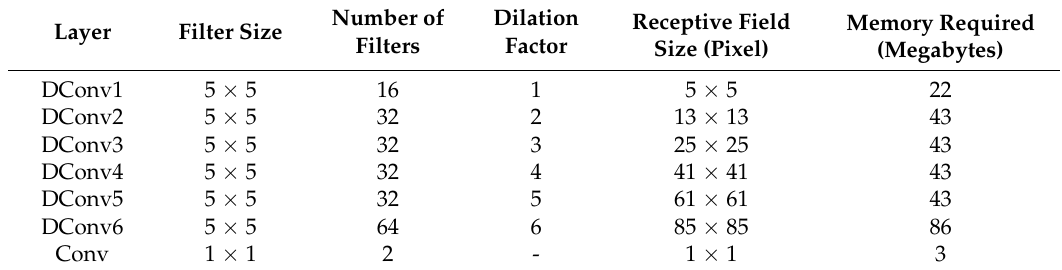
Table 1. The detailed architecture of the network.